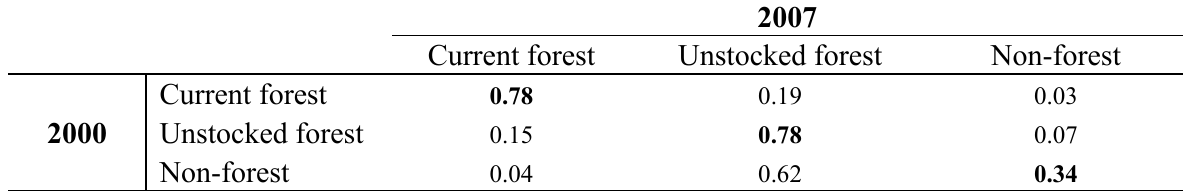
Table 8. Forest cover changes transition probabilities